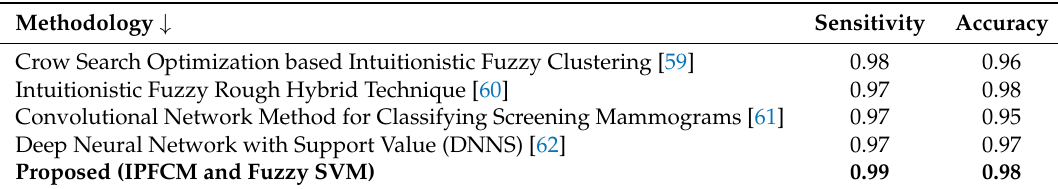
Table 9. Comparative results between the proposed work and the other related